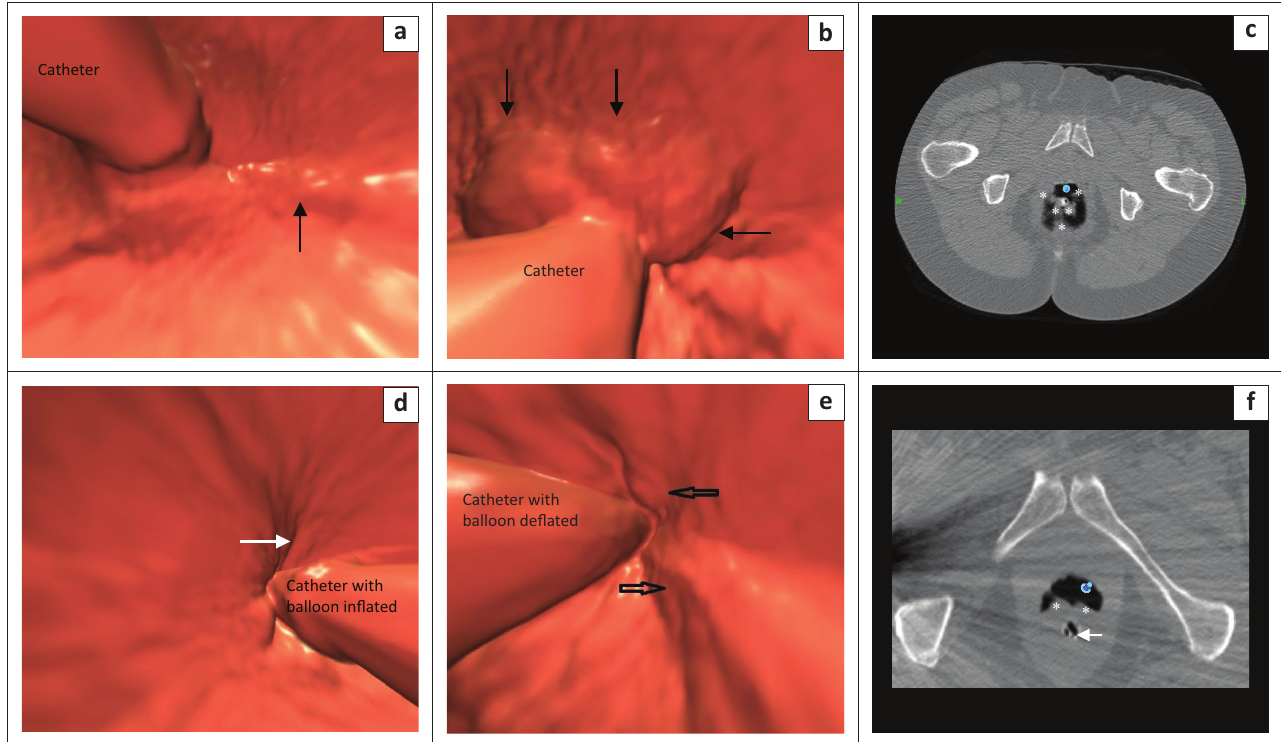
FIGURE 12: (a) Internal haemorrhoid above the dentate line and (b) external haemorrhoids.